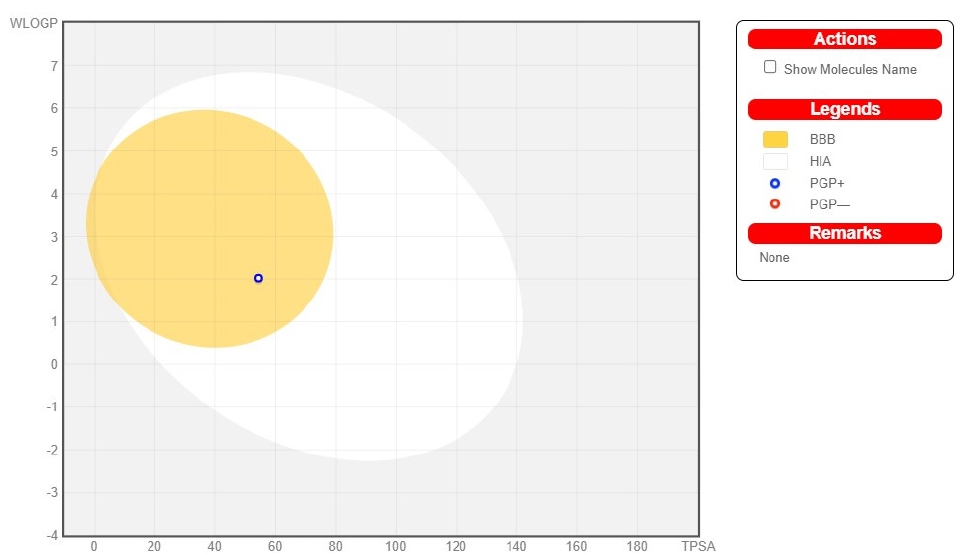
Figure 12. BOILED-Egg diagram for the ligand L1 .